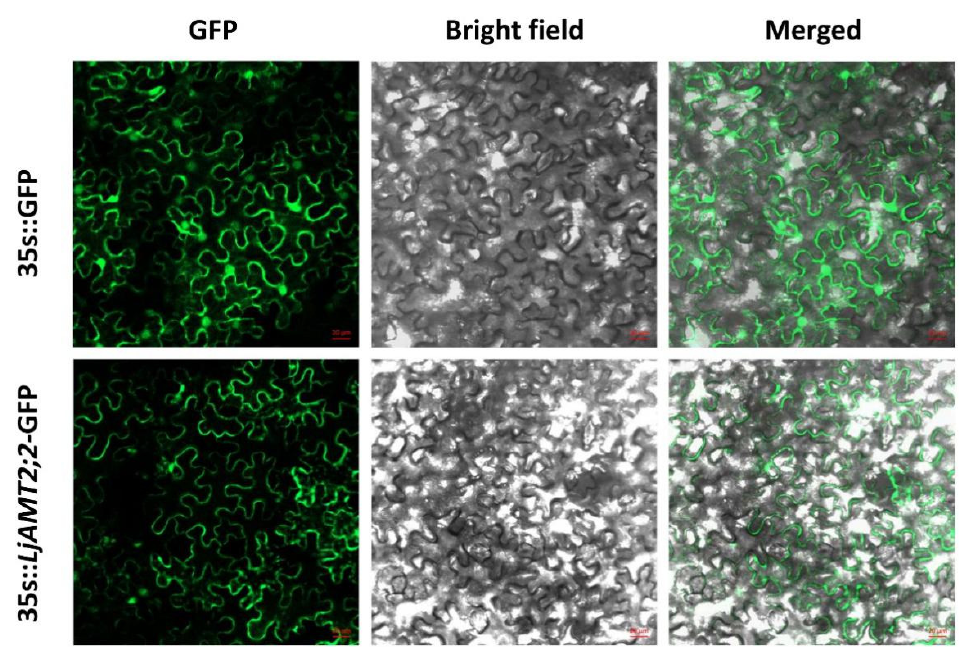
Figure 2. Subcellular localisation of LjAMT2;2 expression. 35s::GFP is an empty carrier, 35s:: LjAMT2;2 -GFP is the target gene. Three visual fields were observed: Green channel (GFP), bright channel (bright-field), and merged. Scale bars, 20 μ M.